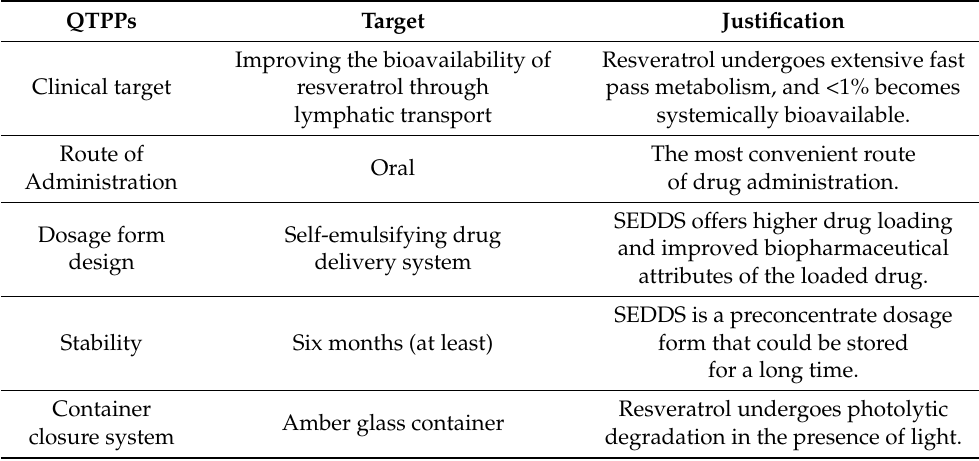
Table 1. QTPP elements with their targets and